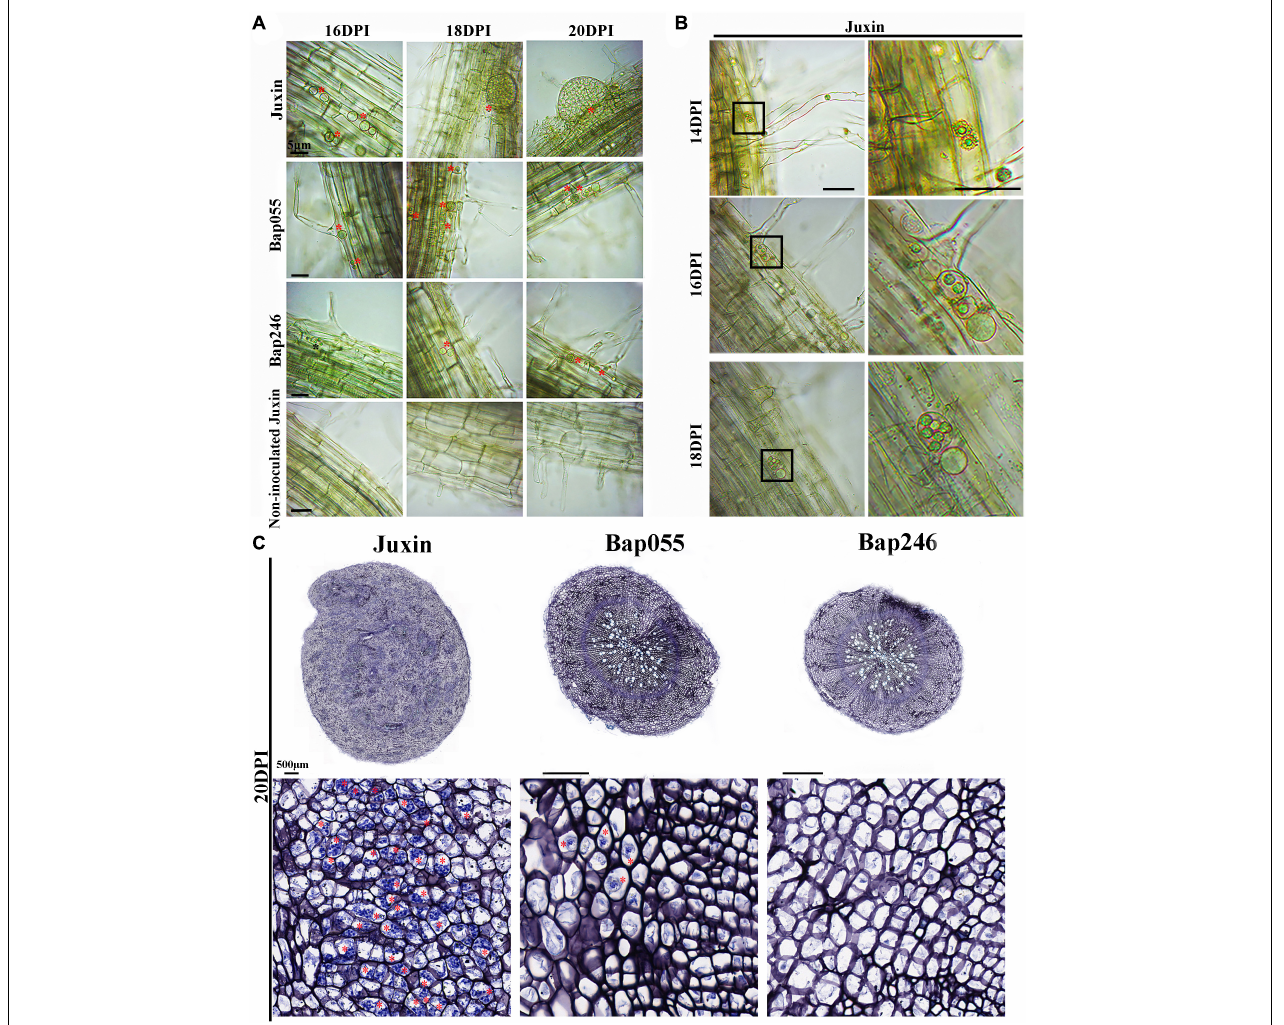
FIGURE 6 | Secondary infection of different Chinese cabbage genotypes by P. brassicae at 16–20 days post-inoculation (DPI). (A) Inverted microscopy images of cortical cells of genotypes “Juxin”, Bap055, Bap246, and non-inoculated “Juxin” at 16–20 DPI, showing multinucleate secondary plasmodia. (B) The changes in secondary plasmodium in “Juxin” at 14–18 DPI, uninucleate secondary plasmodia at 14 DPI, binucleate secondary plasmodia at 16 DPI, and multinucleate secondary plasmodia at 18 DPI. The areas highlighted within the black boxes in the lower panel are enlarged for more detail. (C) Root sections of “Juxin,” Bap055, and Bap246 at 20 DPI. The areas highlighted within black boxes are enlarged for more detail. Multinucleate secondary plasmodia are indicated with red asterisks ( ∗ ), while uninucleate secondary plasmodia are indicated with black